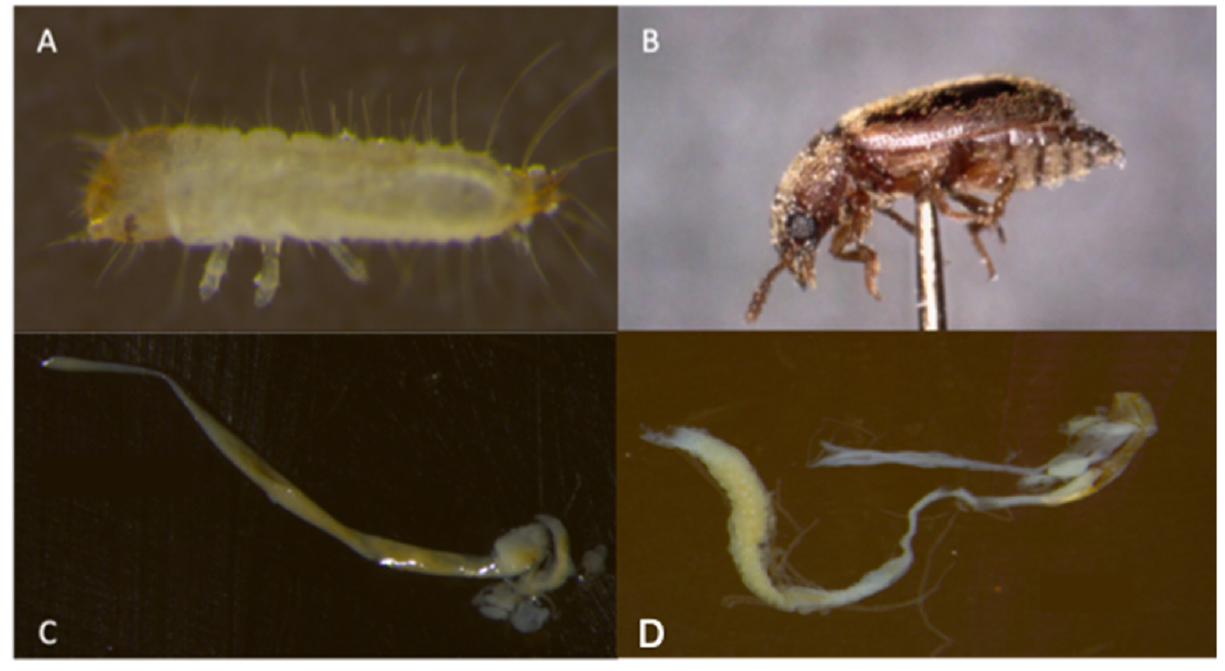
Figure 1. Different life stages of T. stercorea , including their alimentary canal. ( A ) Late instar larva. ( B ) Adult. ( C ) Alimentary canal of late instar larva. ( D ) Alimentary canal of adult.